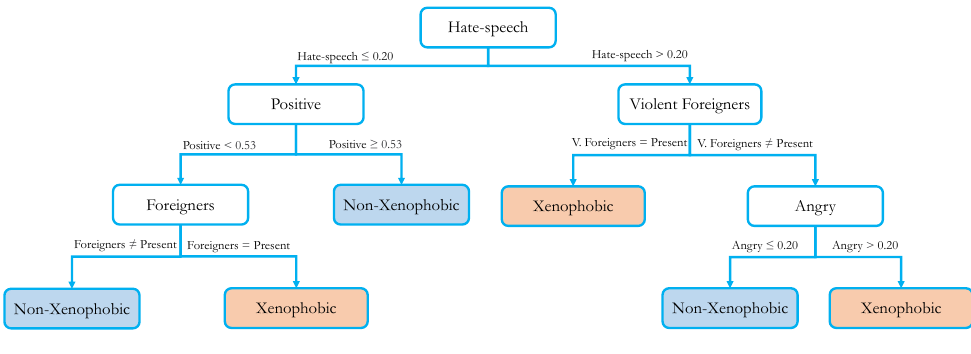
Figure 1. Decision Tree